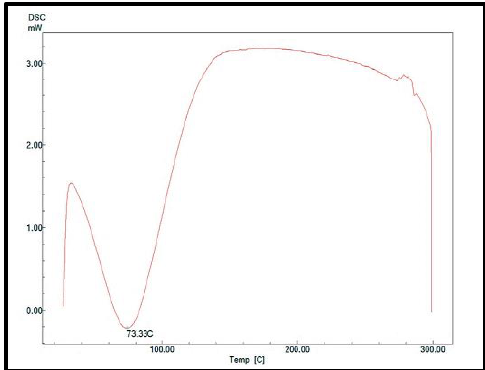
Figure 4. DSC thermogram of liquisolid compact LS-2.